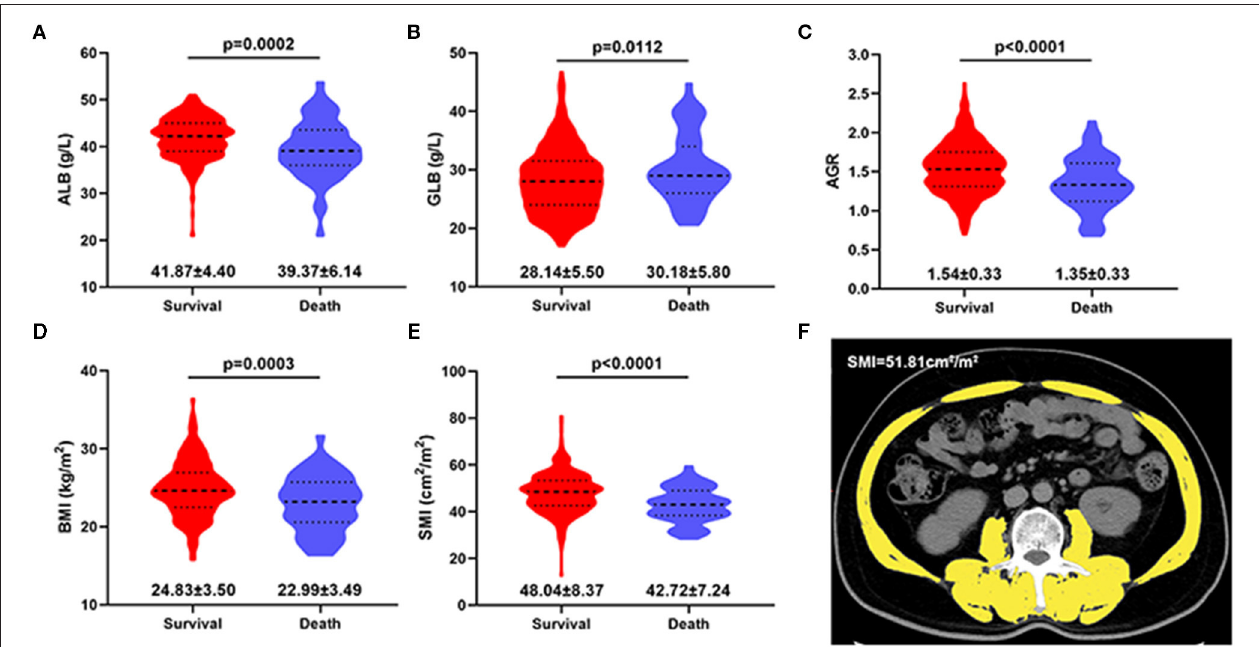
FIGURE 1 | Violin plots showing the preoperative ALB (A) , GLB (B) , AGR (C) , BMI (D) and SMI (E) level in survival and death group at the end of follow-up. (F) Axial CT images of the third lumbar region were used to measure the skeletal muscle index (yellow area). ALB, albumin; GLB, globulin; AGR, albumin to globulin ratio; BMI, Body mass index; SMI, skeletal muscle index. Data are presented as the mean ± standard